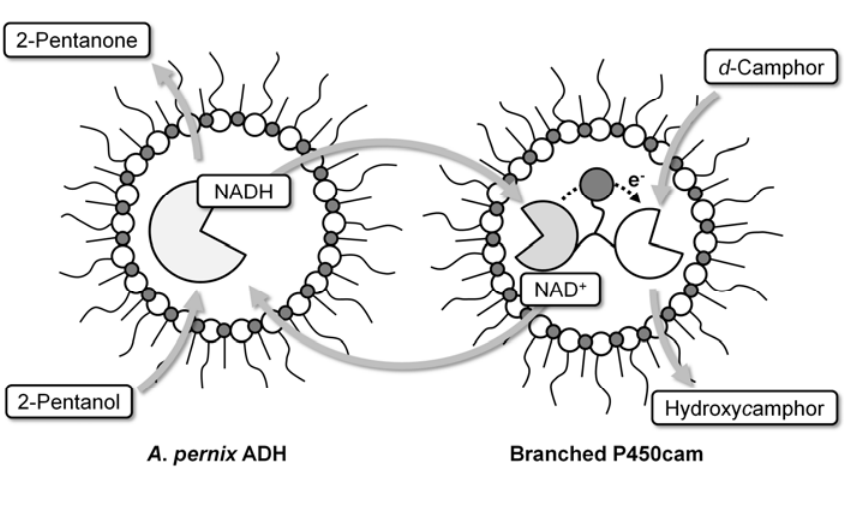
Figure 1. Reaction scheme for d -camphor hydroxylation by branched P450cam with cofactor regeneration in a reversed micellar